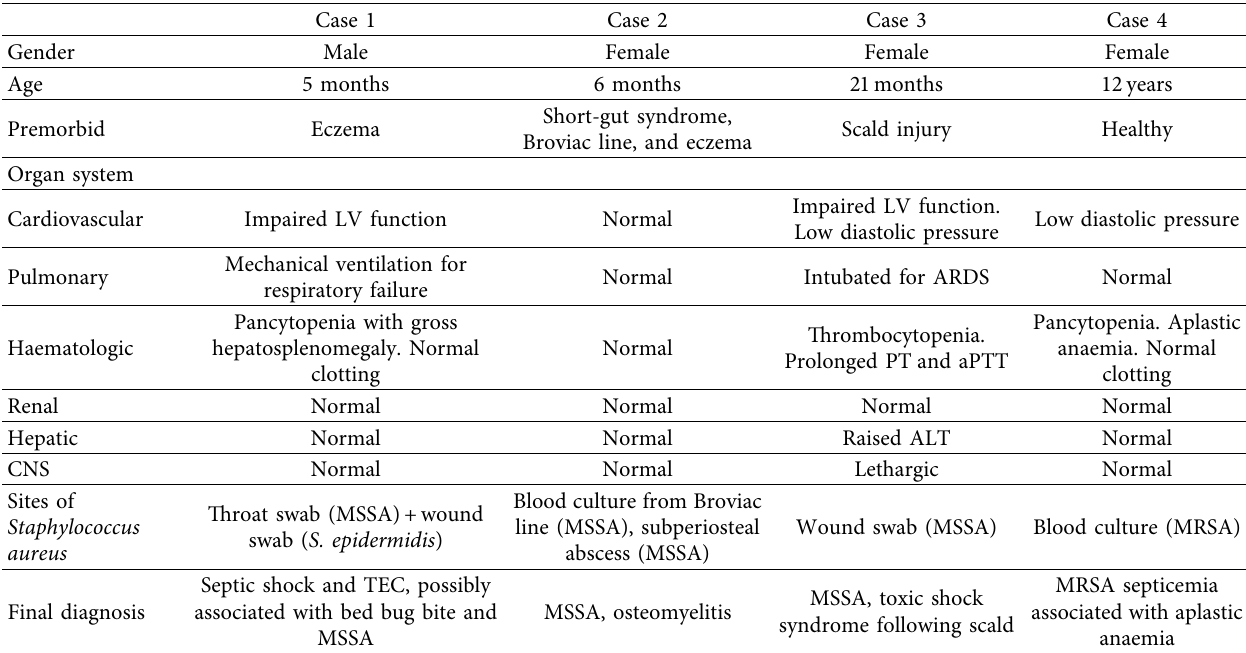
Table 1: Staphylococcus aureus disease in the